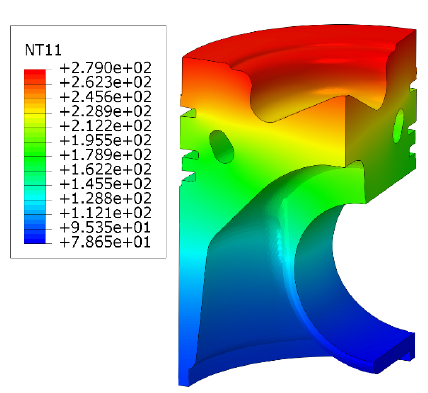
Fig. 7. Temperature field of the piston substrate with 60 µ m